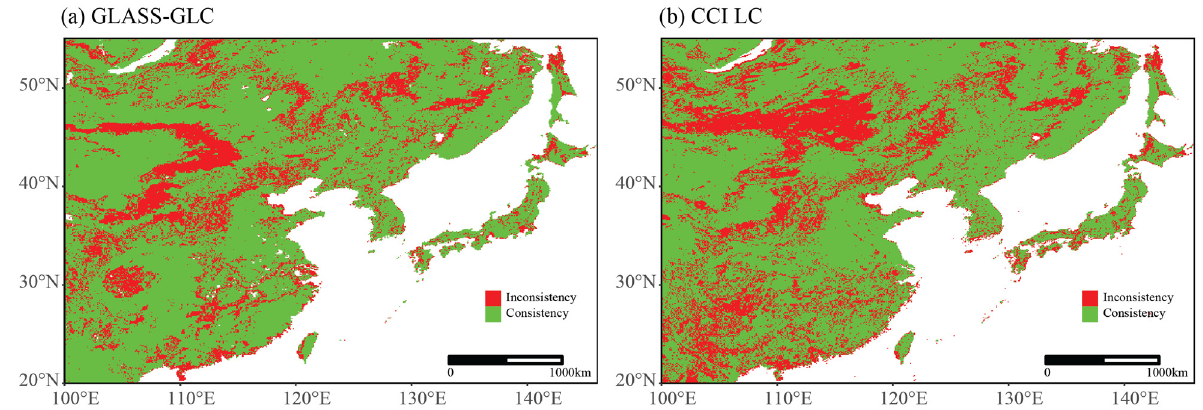
Figure 4. Spatial consistency between the classification map with ( a ) GLASS-GLC in 2014 and ( b ) CCI LC in 1996.